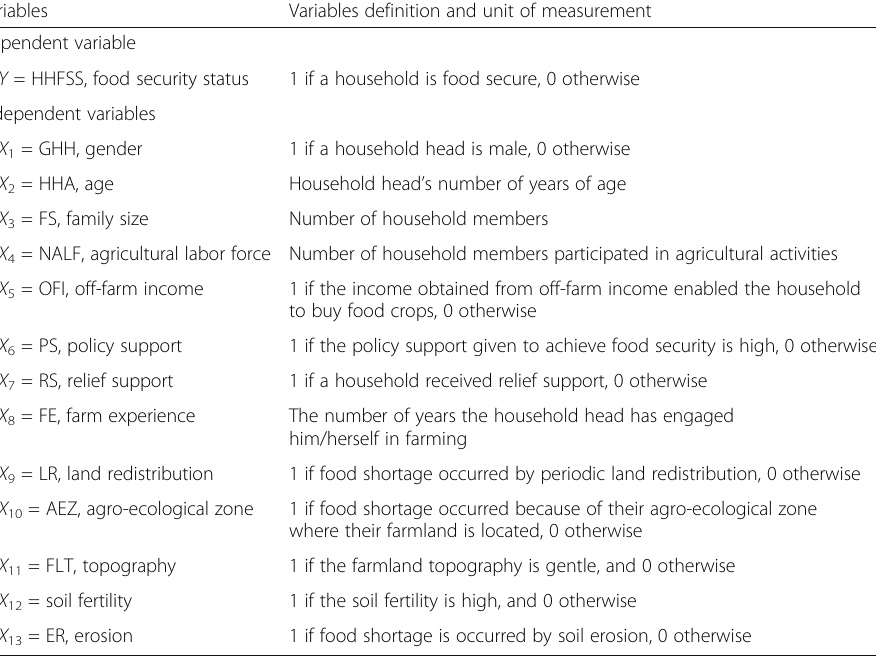
Table 5 Description of variables used in the logistic regression model Variables